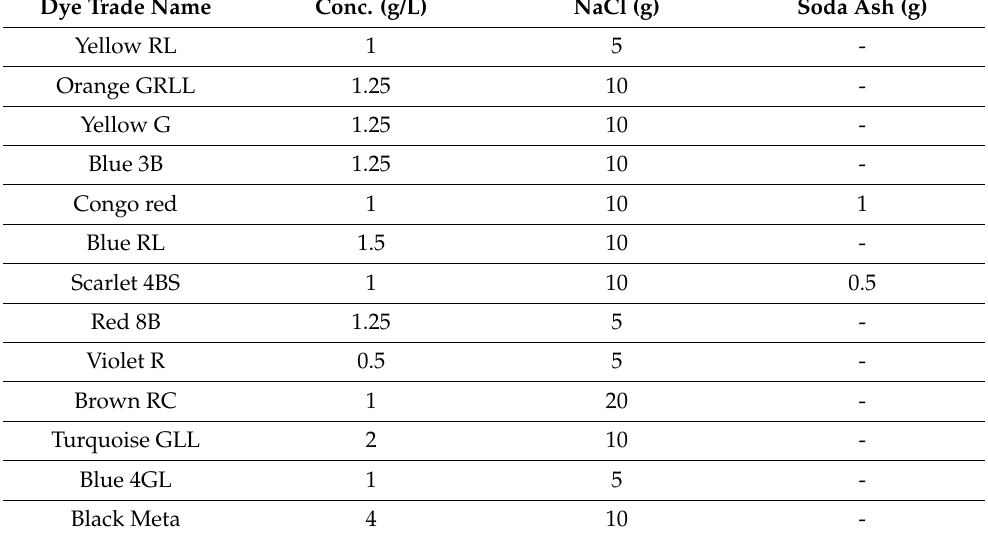
Table 2. Dyeing experimental